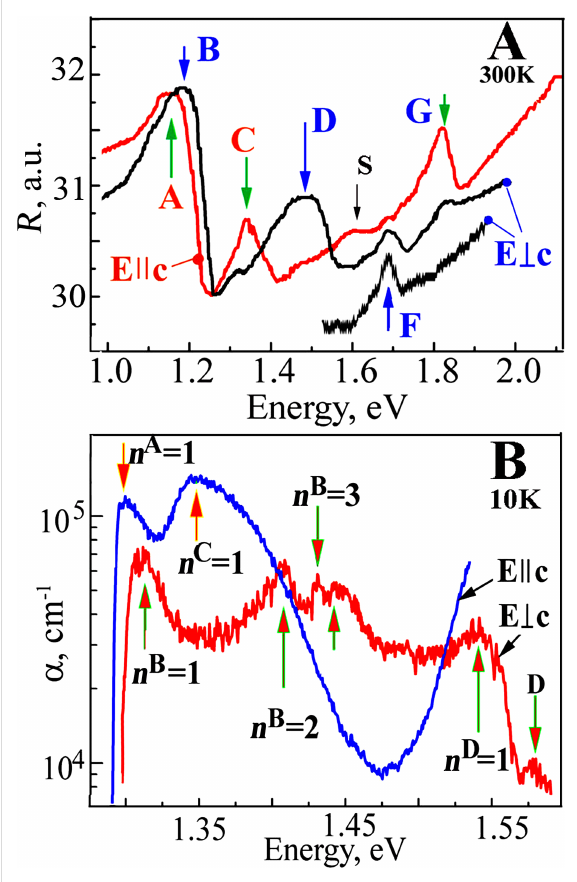
Figure 5: (A) The reflection spectra of the Sb 2 Se 3 crystal measured at room temperature for both E ||c and E ⟂ c polarization conditions. (B) The edge absorption of the Sb 2 S е 3 crystal with a thickness d = 1.3 μ m for Е || с and Е ⟂с polarization conditions at a temperature of 10 K.